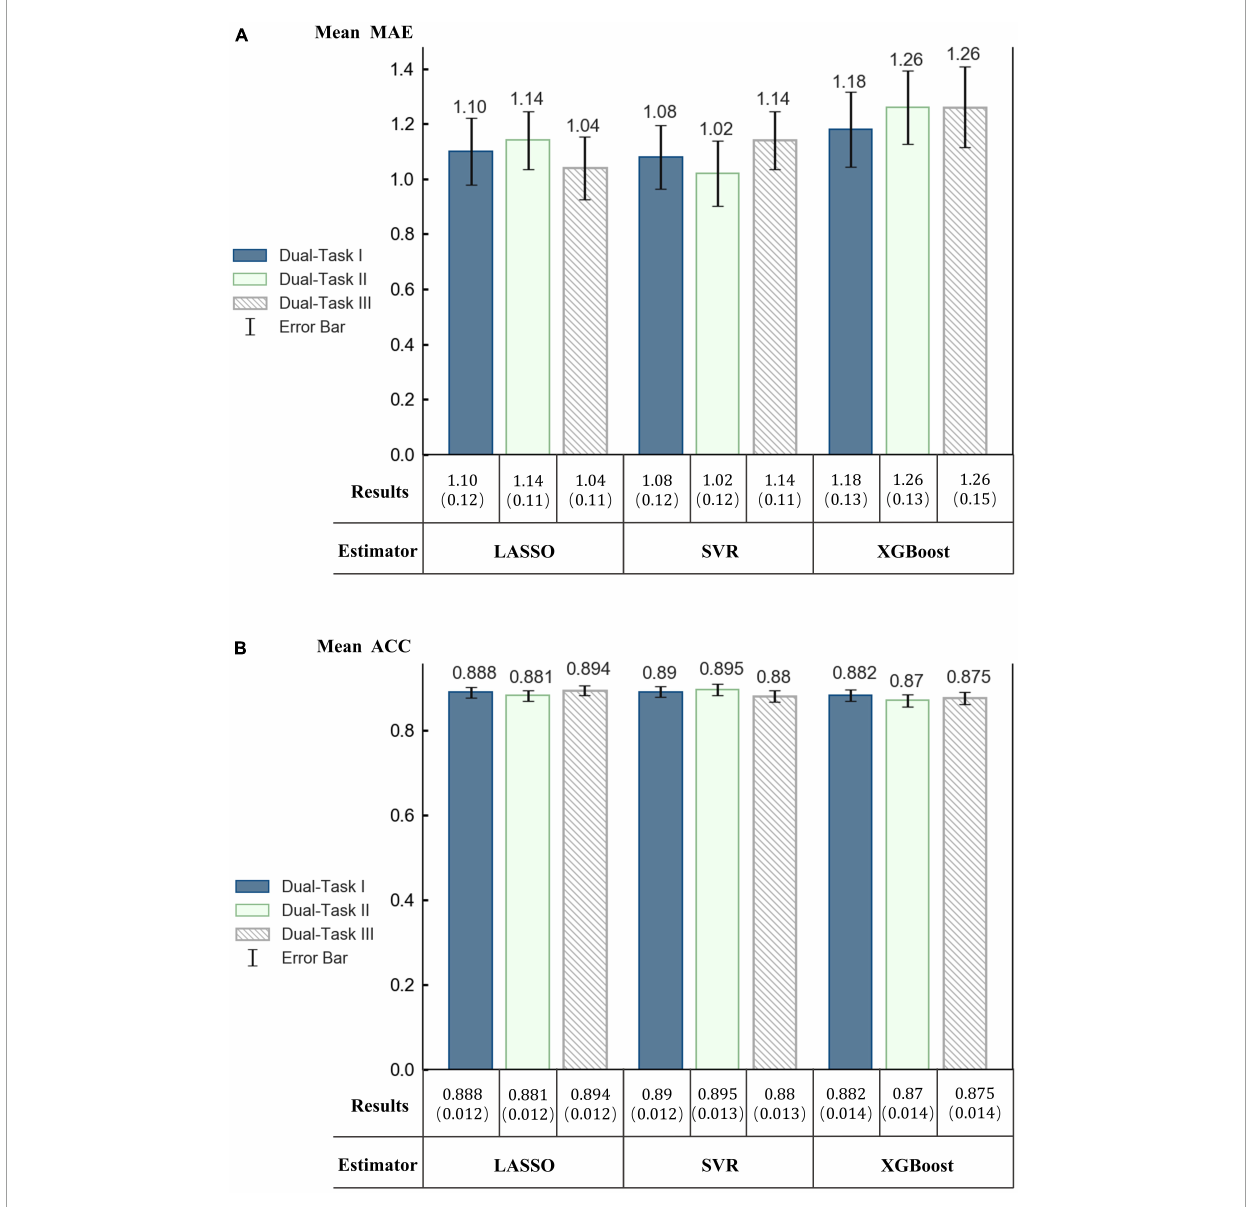
FIGURE8 Performance of regression models using three dual-tasks separately. (A) Mean MAE and the standard error of the mean (SEM) in parentheses. (B) Mean ACC and SEM in